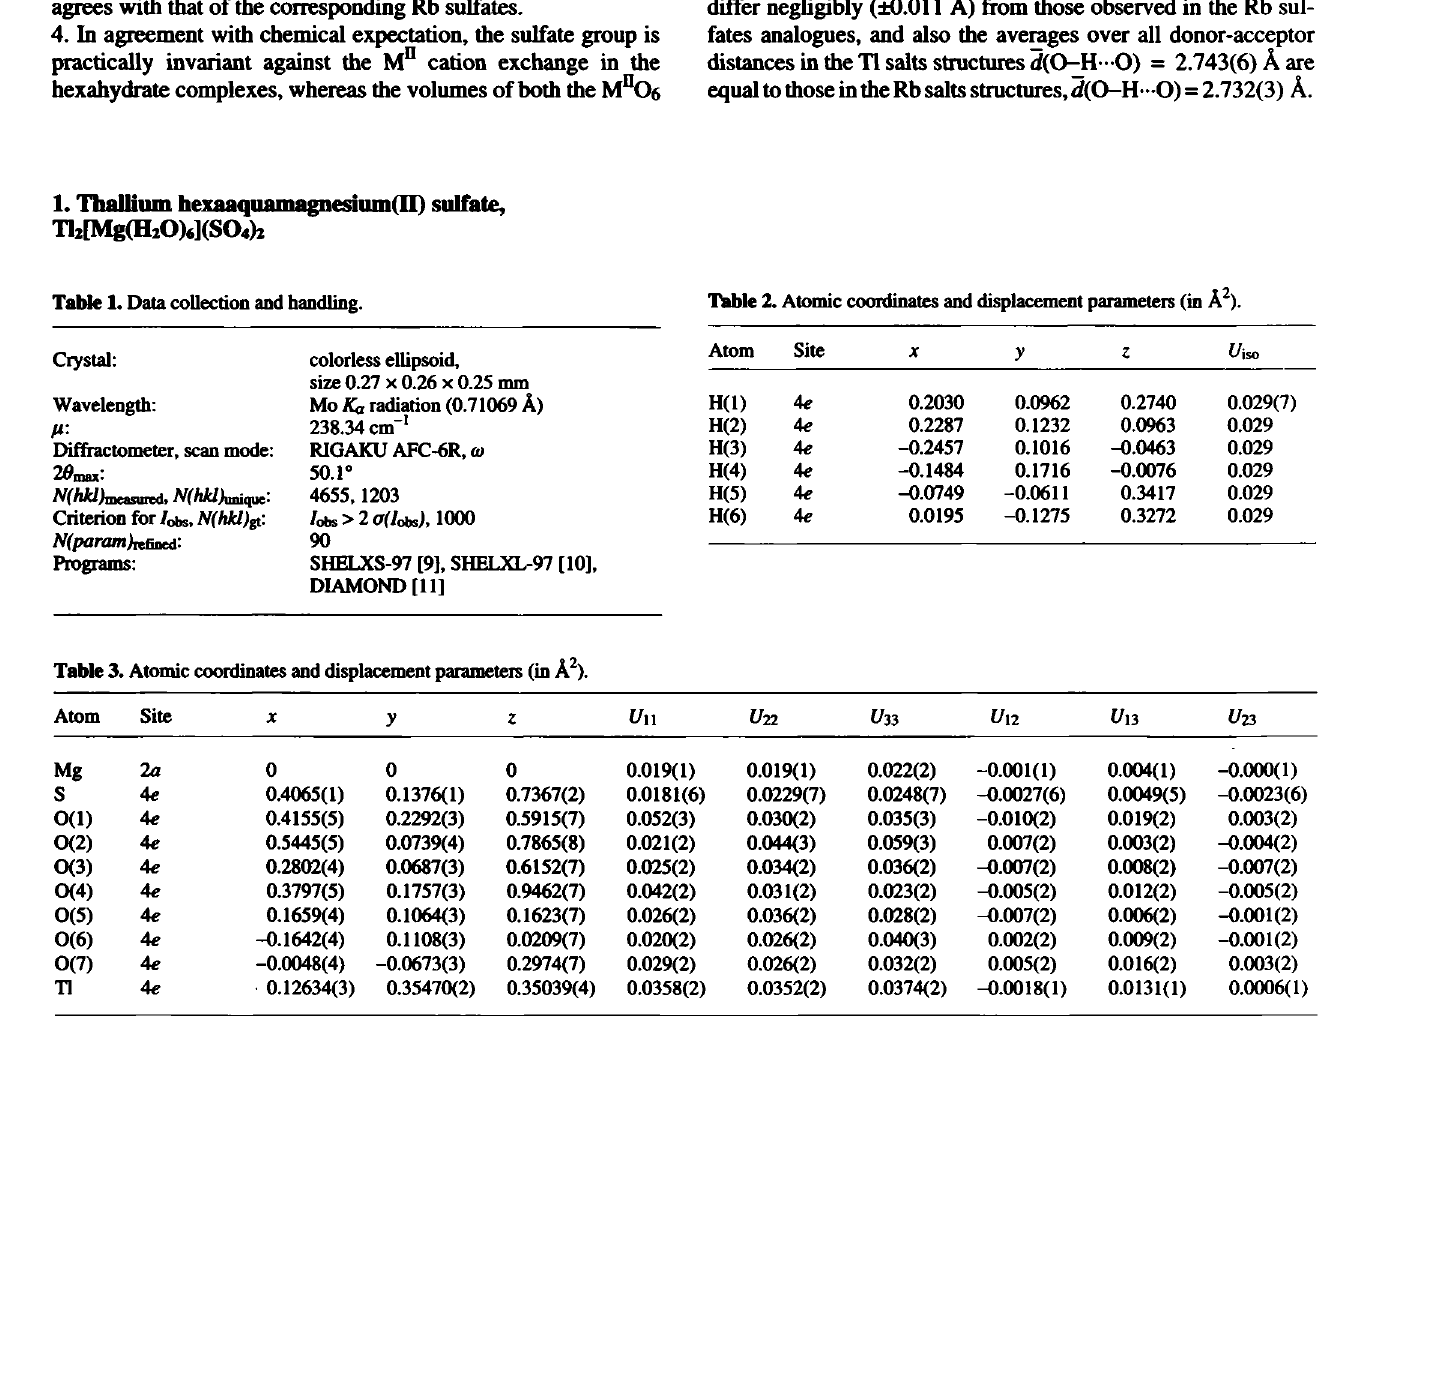
Table 1. Data collection and handling. Table 2. Atomic coordinates and displacement parameters (in Â 2 ).